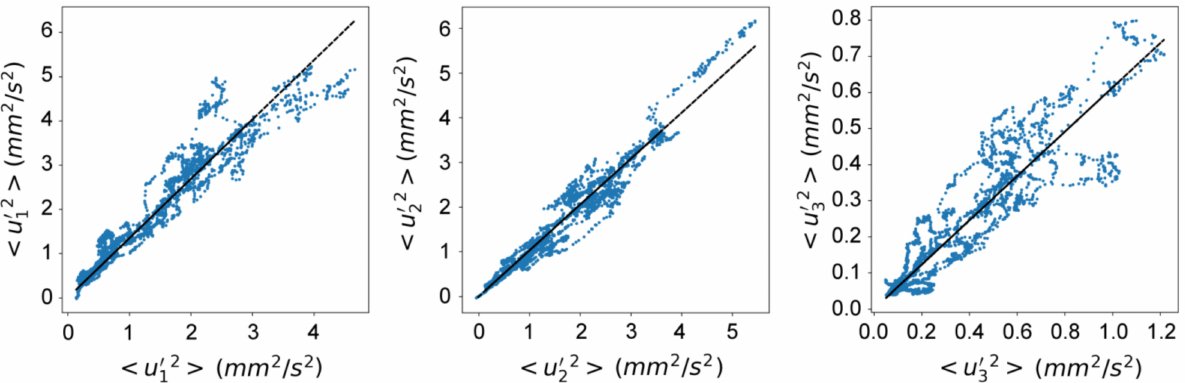
Figure 6. Correlations between the pulsation intensities, derived by two independent methods. Projection of each point on the X and Y axes represent the values, obtained by the coupled-ADCPs and single-ADCP methods correspondently. The linear regression curves are presented by black dashed lines.